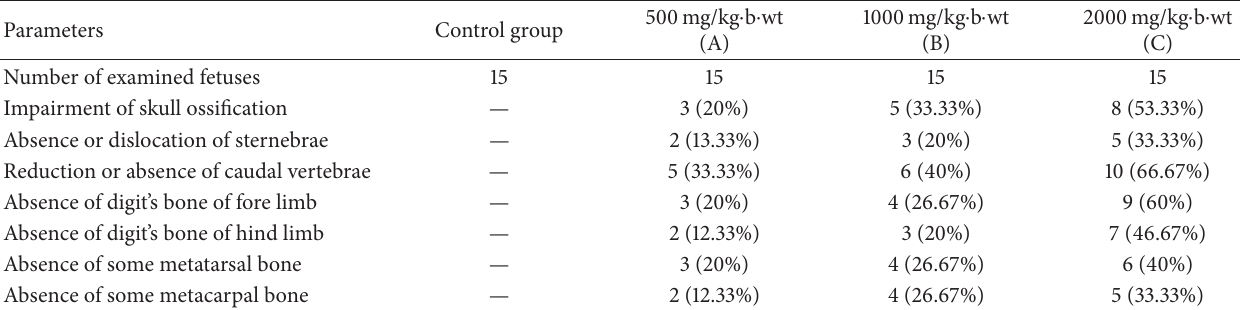
Table 3: Skeletal abnormalities in fetuses obtained from pregnant female rats after repeated oral administration of 500, 1000, and 2000 mg